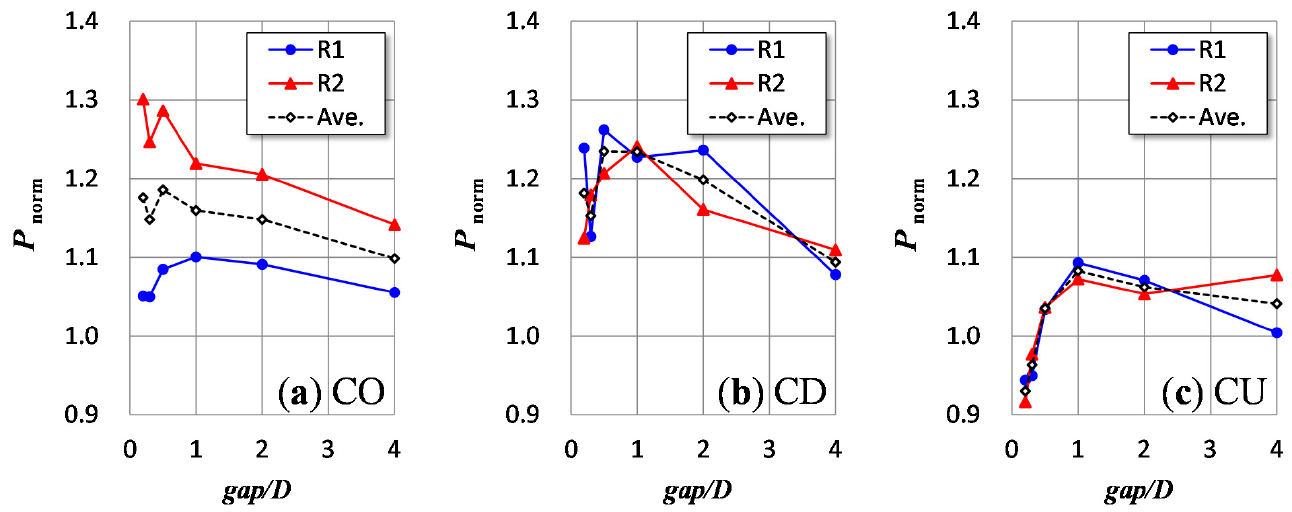
Figure 10. Gap dependence of normalized power of each rotor: ( a ) CO layout; ( b ) CD layout; ( c ) CU layout.